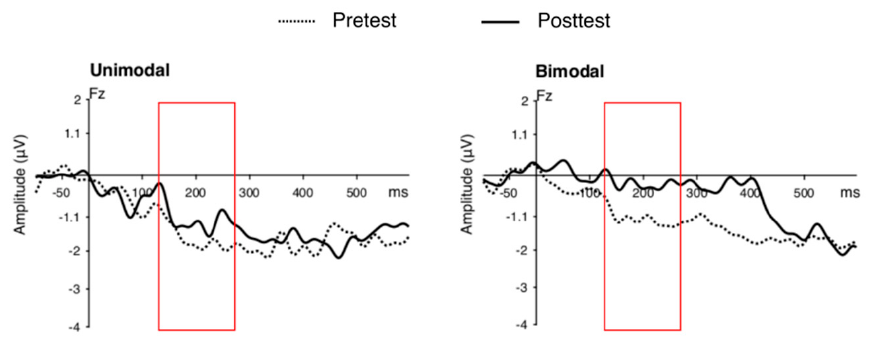
Figure 5. Grand-averaged MMN component by unimodal ( left ) and bimodal ( right ) condition. Dotted lines show the MMN component at pre-training and solid lines represent the MMN component at post-training. The red boxes highlight the time window in which the MMN amplitude peaks were measured (i.e., 120–270 ms post-stimulus onset to account for consonant production).